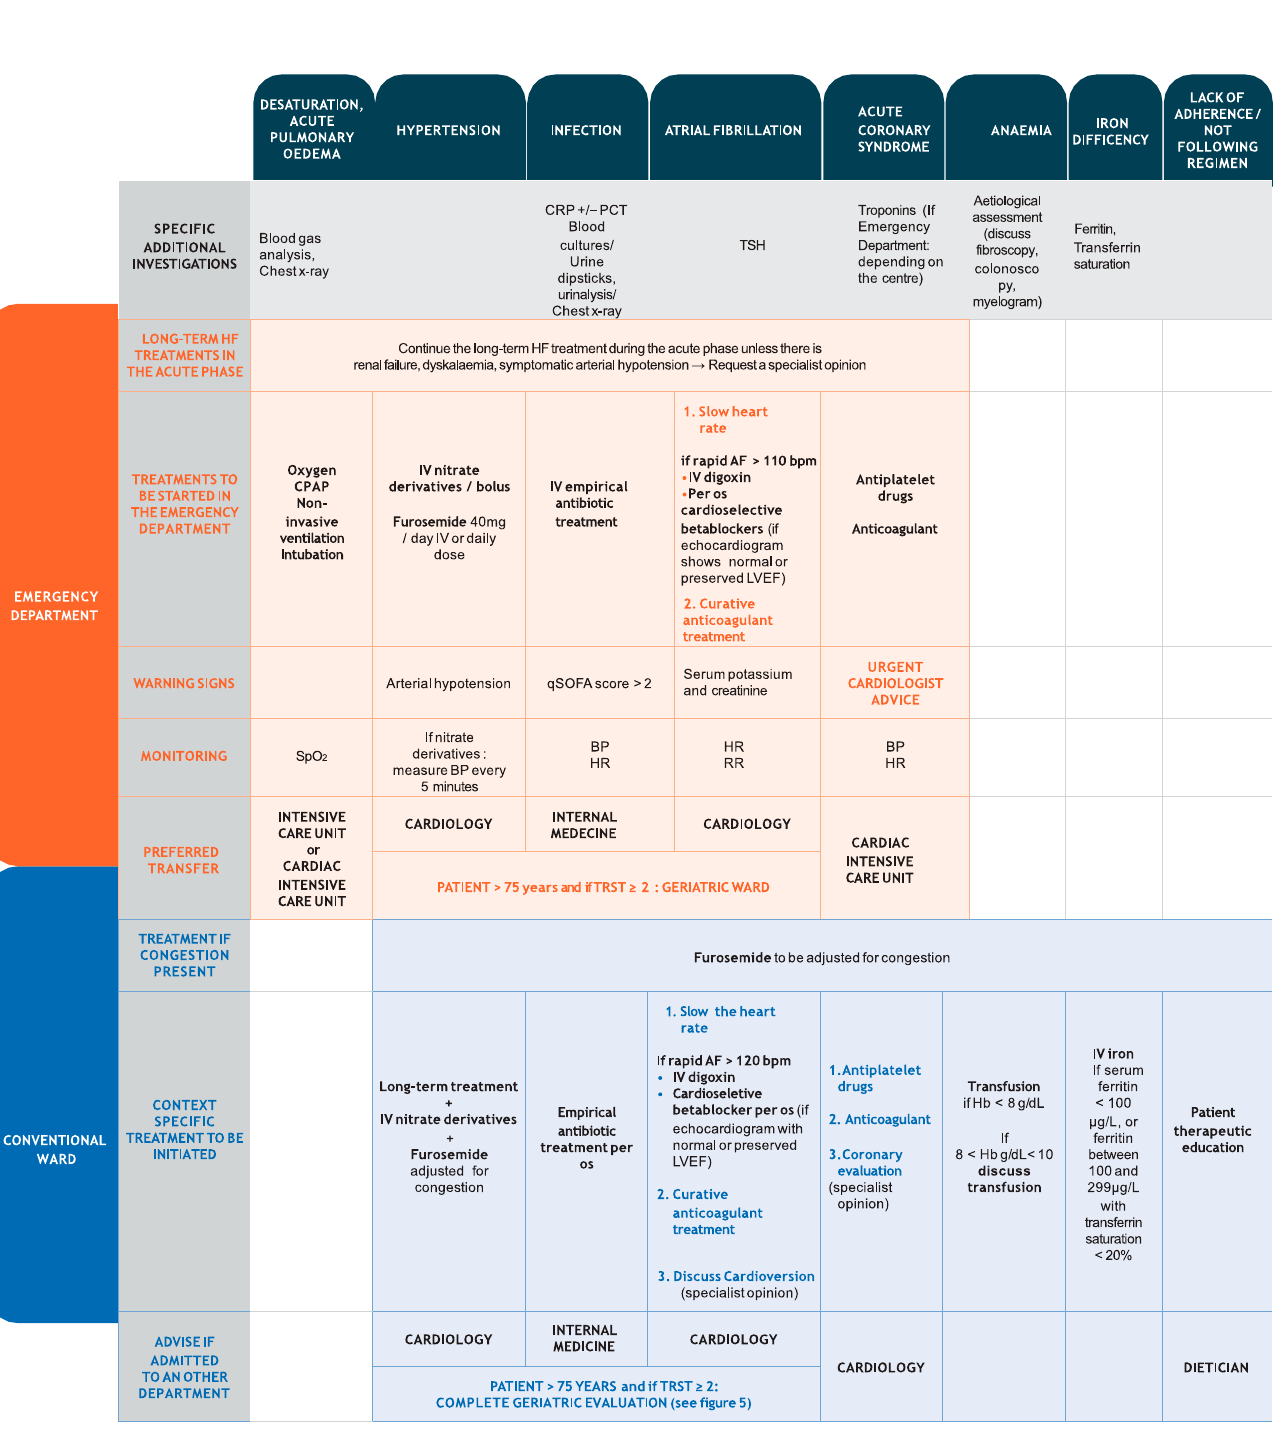
Figure 3. Therapeutic management. This figure was developed using expert consensus, guidelines and recommendations